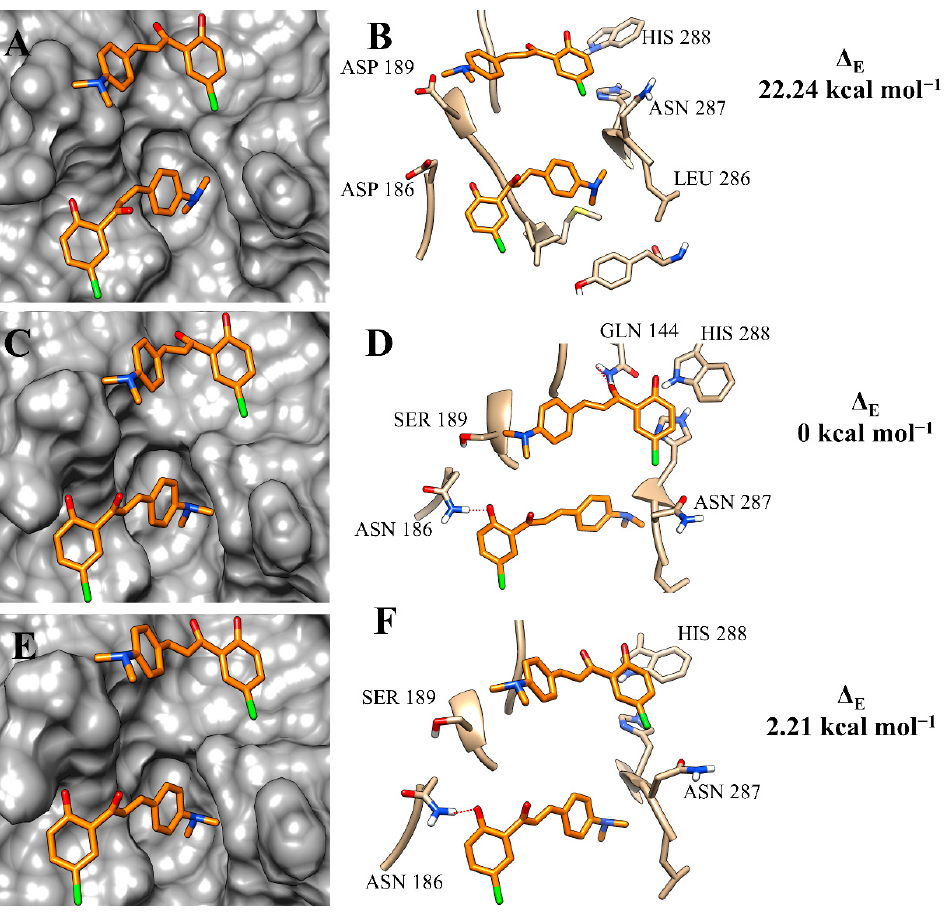
Figure 5. Binding mode positions of chalcone 3c at the active site of rCPB2.8 ( A , B ), rCPB3 ( C , D ), and rH84Y ( E , F ). The hydrogen bonds are represented by a red dashed line.